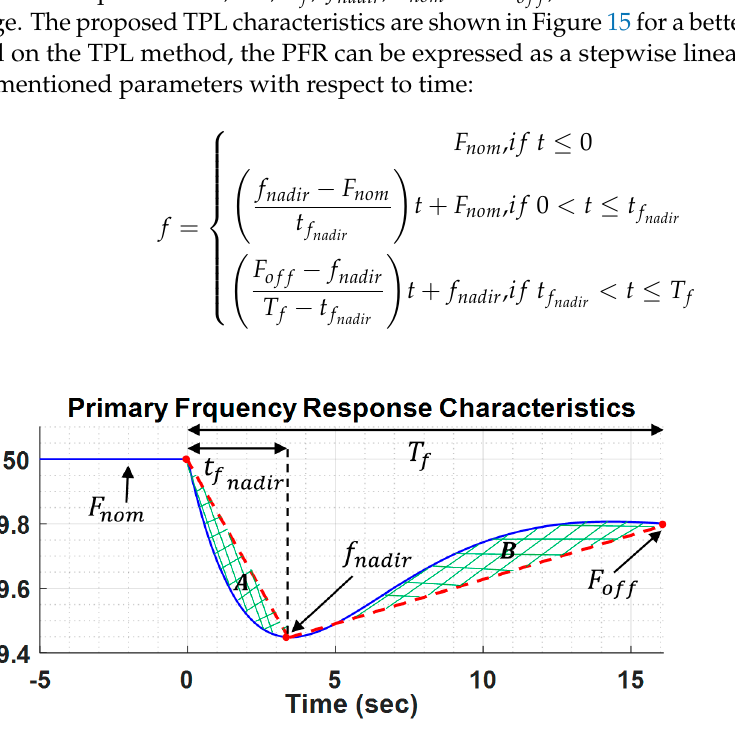
Figure 15. Proposed Three-Point Linearization technique to represent PFR characteristics.